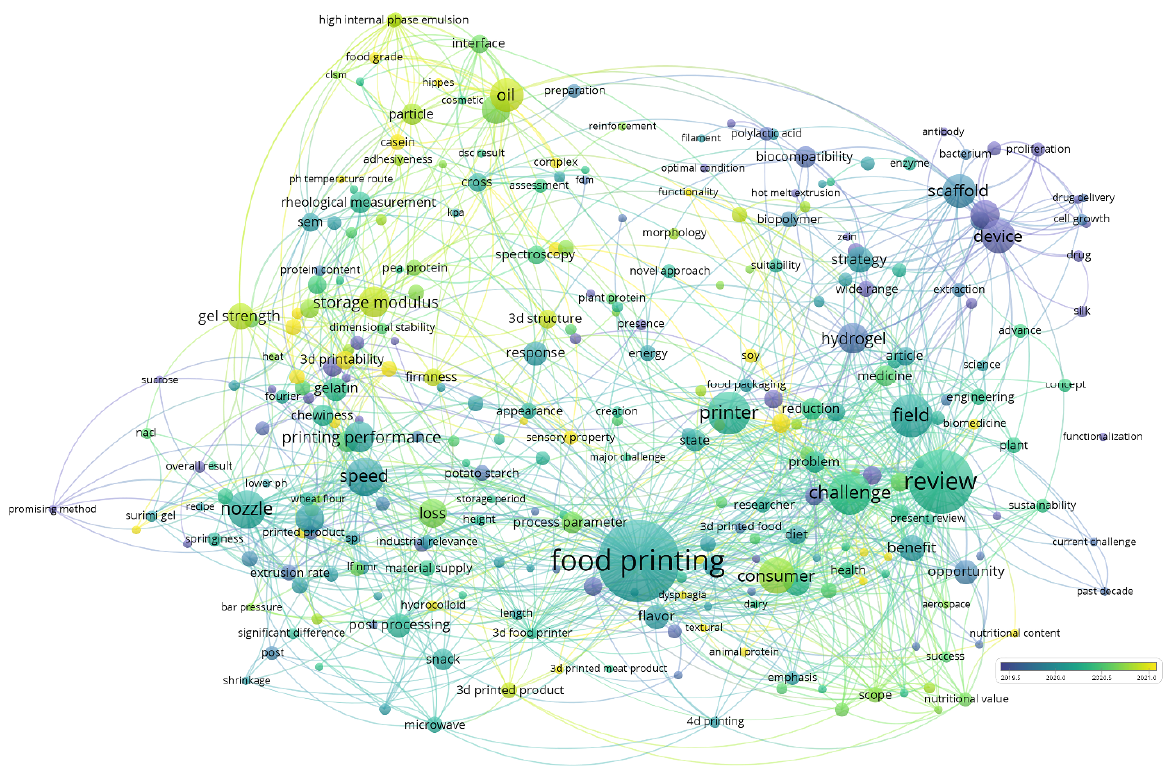
Figure 1. Analysis results of “food 3D printing protein” hotspots in recent